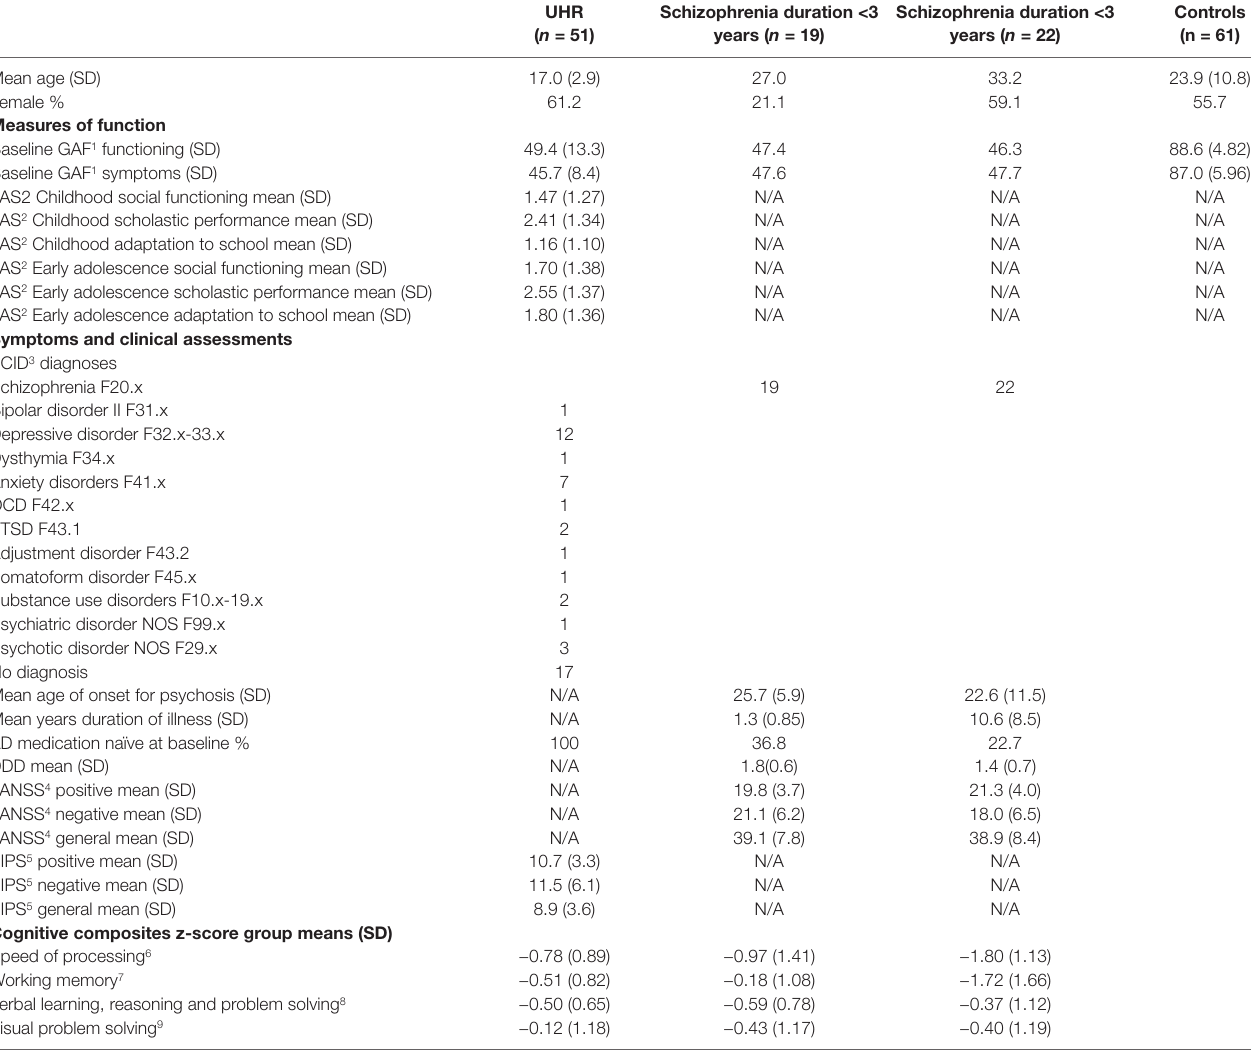
TABLE 1 | Demographic variables and baseline cognitive test scores by